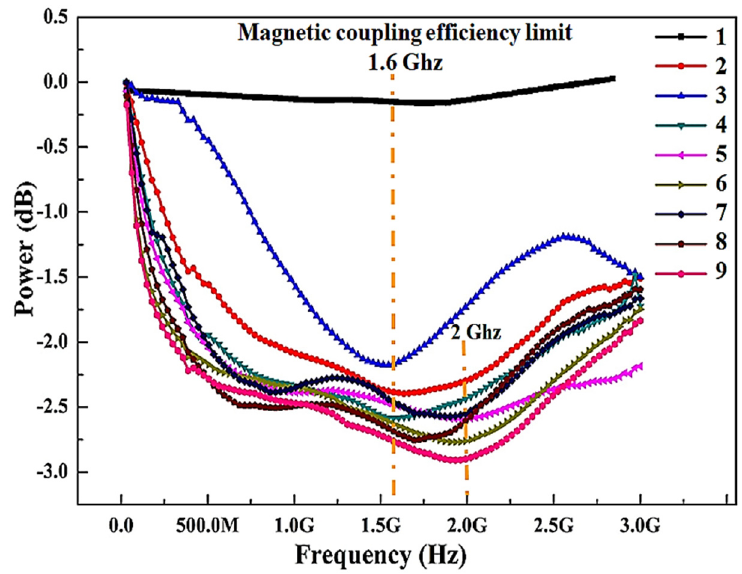
Figure 8. Magnetic coupling efficiency limit dependence on the composition and sputtering parameters of flexible thin film samples.